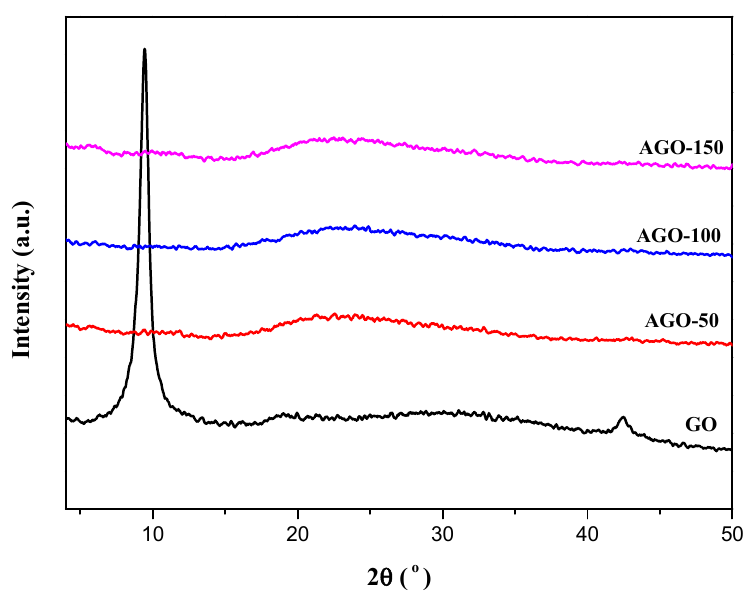
Figure 4. XRD spectra of GO and 3-aminopropyltriethoxysilne functionalized-GO (AGO-50, AGO-100, and AGO-150).